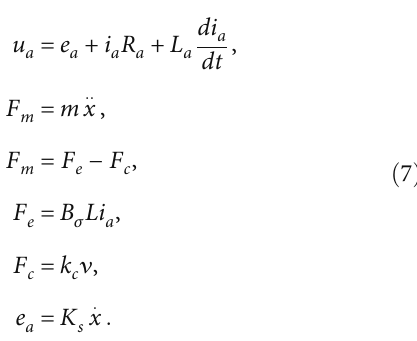
Figure 2: Voice coil motor structure